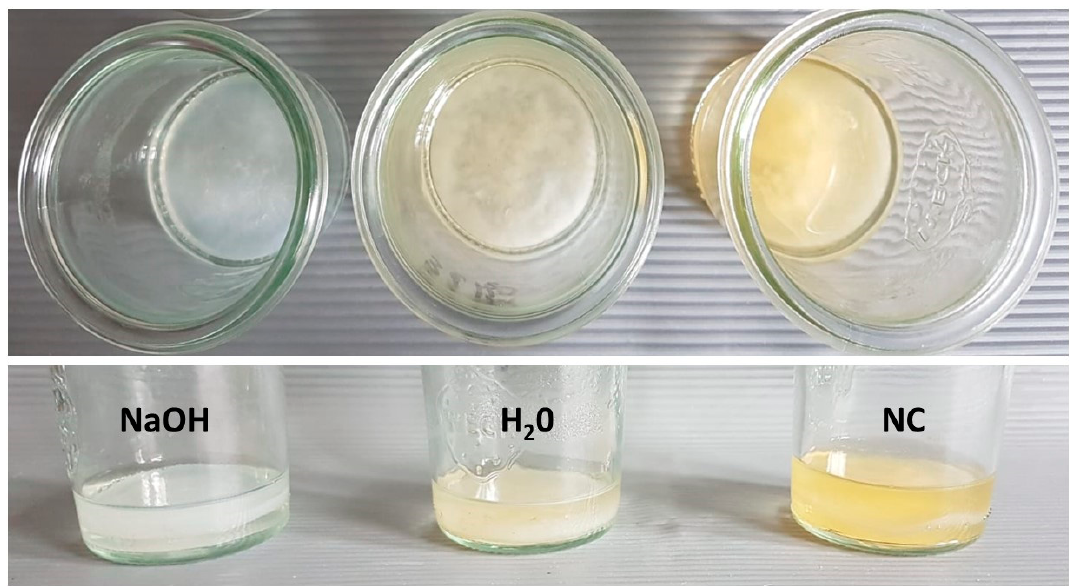
Figure 1. NBC cultured in glass vessel took form of cylinder of 50 mm diameter. The upper panel shows the top, while the lower panel the side plane of 3 days old NBC carriers subjected to K. xylinus cells full removal (NaOH, alkaline lysis) or to process of auto-claving in water (H 2 O), or NBC which was not subjected to any cleansing process (not-treated, NC).